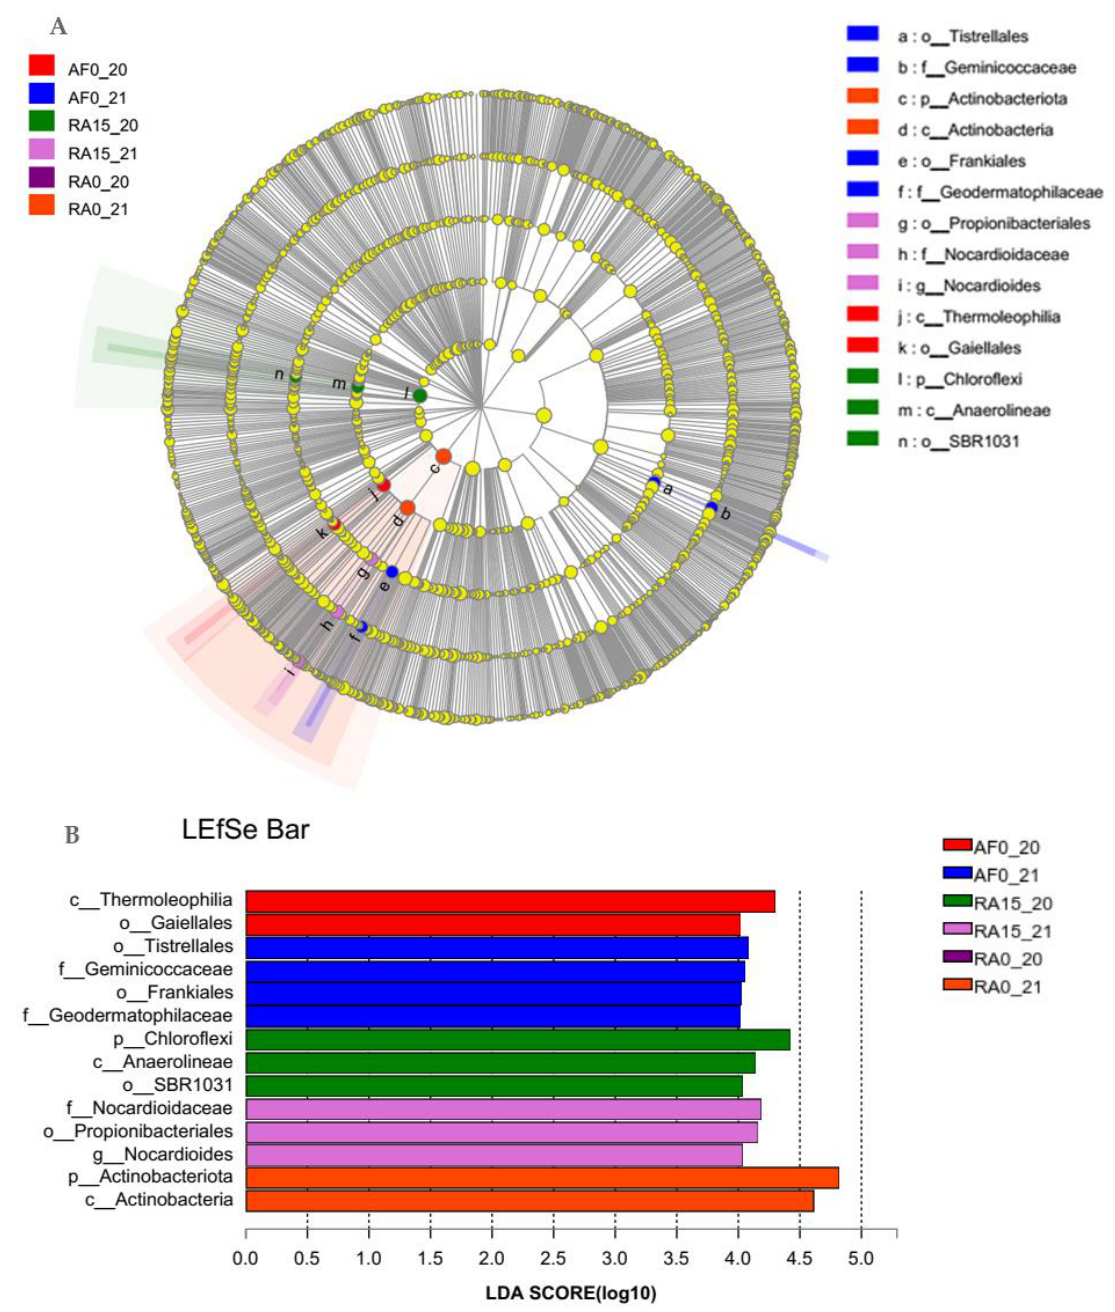
Figure 3. LEfSe cladogram ( A ) and bar ( B ) of different treatments.